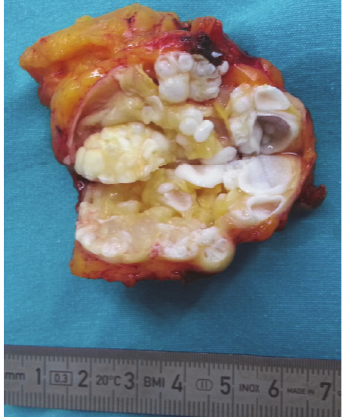
Figure 6: The surgical specimen showed characteristic daughter cysts of hydatid